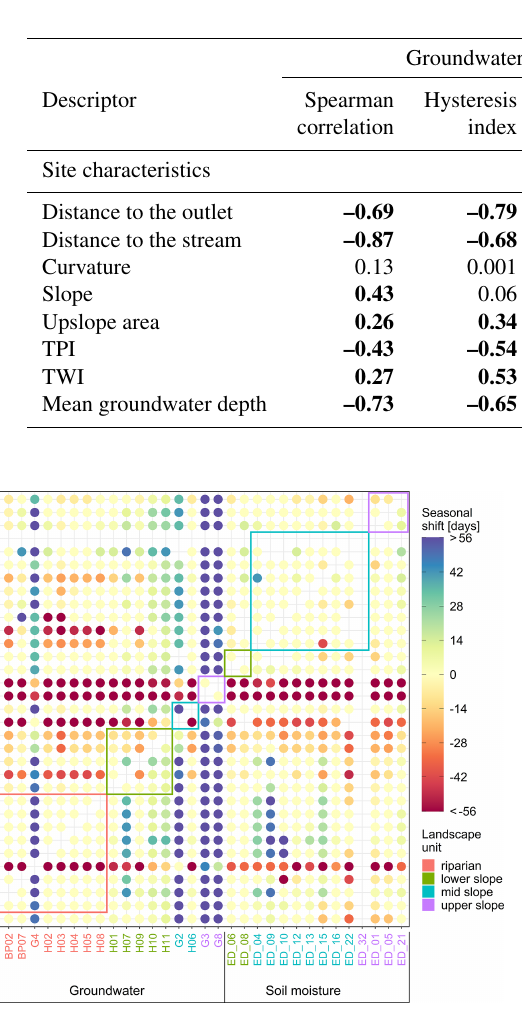
Figure 15. Median seasonal shift between median weekly stream- flow at catchment outlet ( Q ), groundwater (BP ∗∗ , H ∗∗ , G ∗ ) and soil moisture (ED_ ∗∗ ) over the years 2017 and 2018. The seasonal shift is positive if the row station’s seasonal maxima and minima occur before the maxima and minima of the column station and vice versa. Circles’ colour corresponds to the value of the seasonal shift. The station names’ colour corresponds to their landscape unit. Coloured rectangles enclose values of stations in the same landscape unit. Only time series longer than 45 weeks per year are